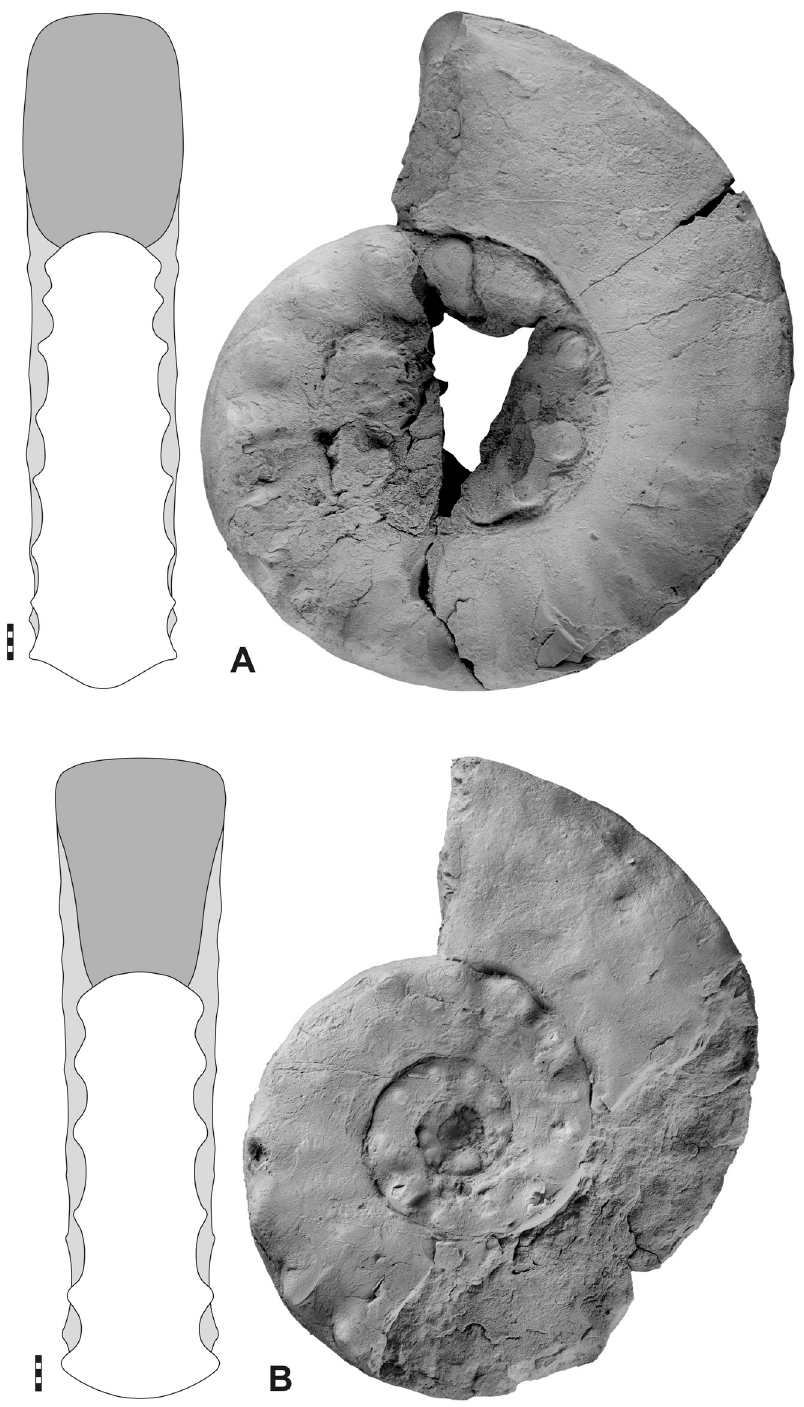
Fig. 34. Paratirolites baghukensis Korn & Hairapetian sp. nov. A . Paratype MB.C.29850, section 1, -2.70 m. B . Paratype MB.C.29874, section G, float. Scale bar units = 1